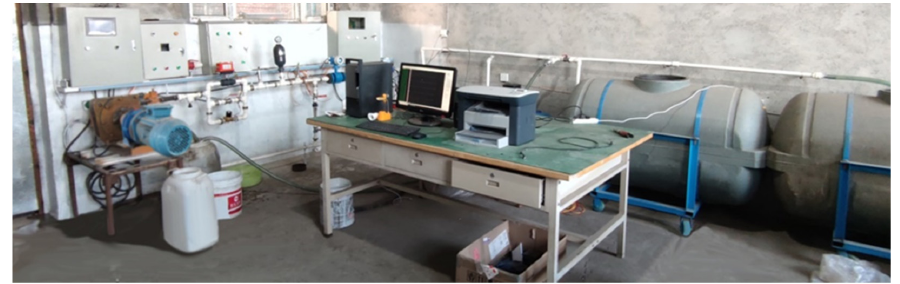
Figure 10. Flow regulation test platform.